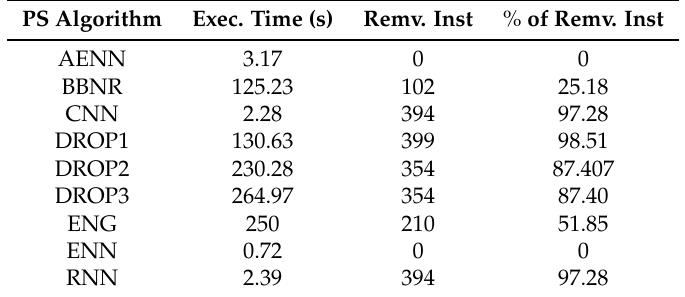
Table 2. Analysis of PS algorithms in relation to optimization embedded computational resources.